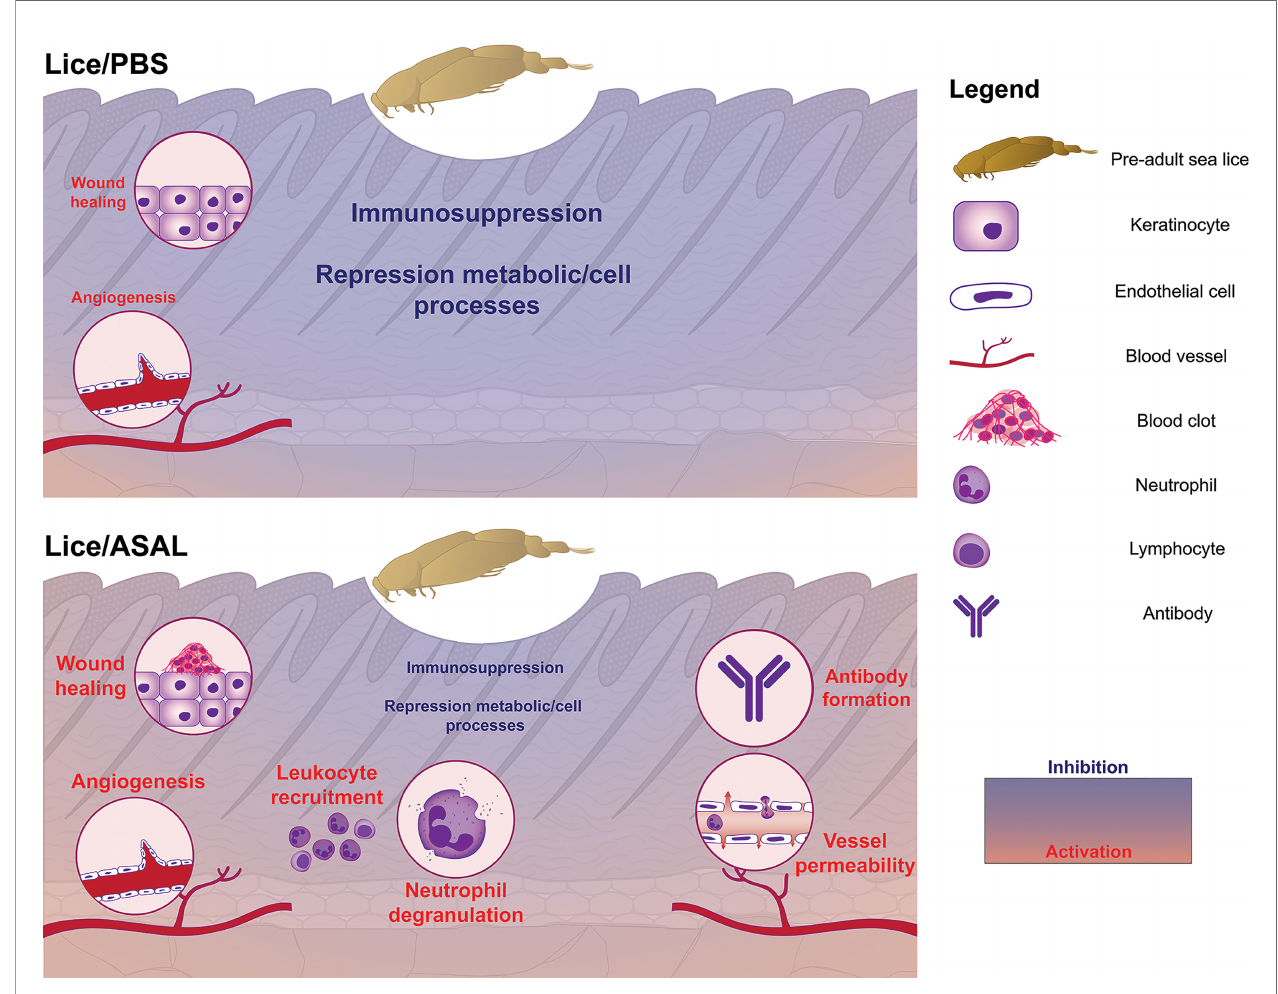
FIGURE 11 | Summary of the main biological processes putatively regulated in response to sea lice infection in the skin of PBS-injected (Lice/PBS; top) and ASAL- injected (Lice/ASAL; bottom) Atlantic salmon, as explained in the Discussion. Biological processes ’ names are colored based on whether they were inhibited (blue) or activated (red); their font sizes are proportional to their inhibition/activation extent. The stylized skin section used as the background was colored with a blue-red gradient color scheme representing the proportion of down-regulated/up-regulated genes in the Lice/PBS and Lice/ASAL